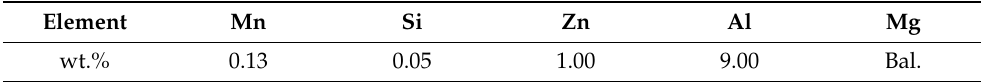
Table 1. The chemical composition of the AZ91 Mg alloy.